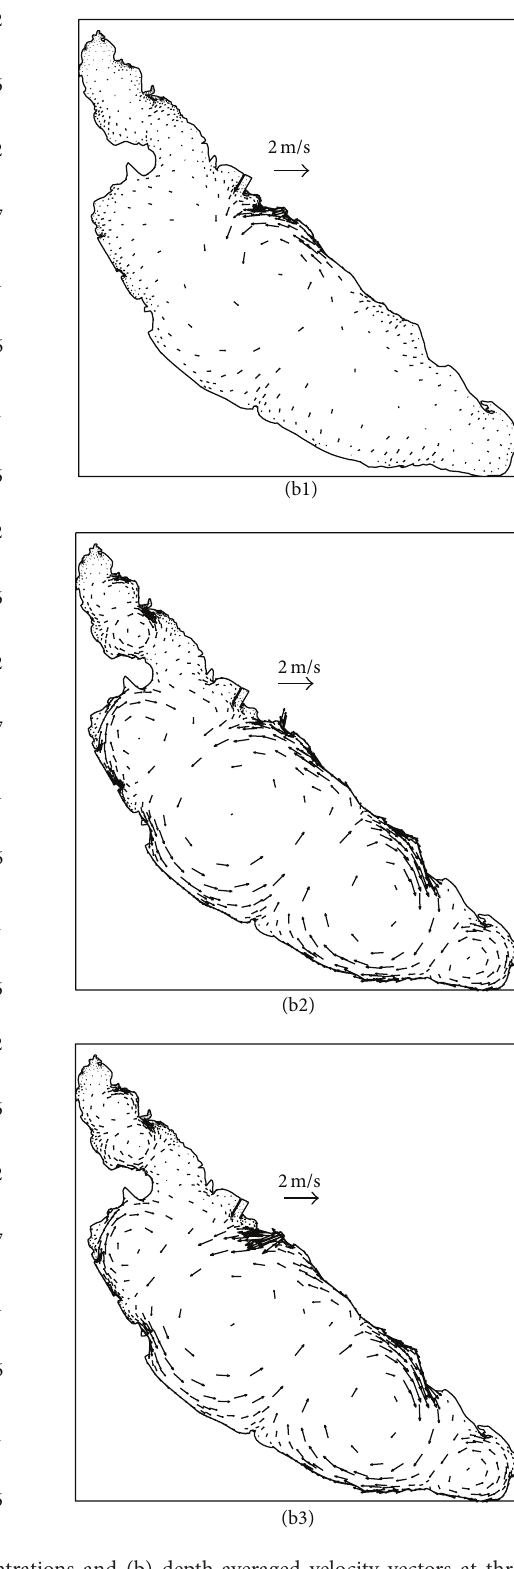
Figure 3: Spatial distributions of predicted (a) contaminant concentrations and (b) depth-averaged velocity vectors at three different simulation times (from top to bottom 𝑡 = 1 h, 3 days, and 6 days) for tidal flushing through Inlet 𝑂